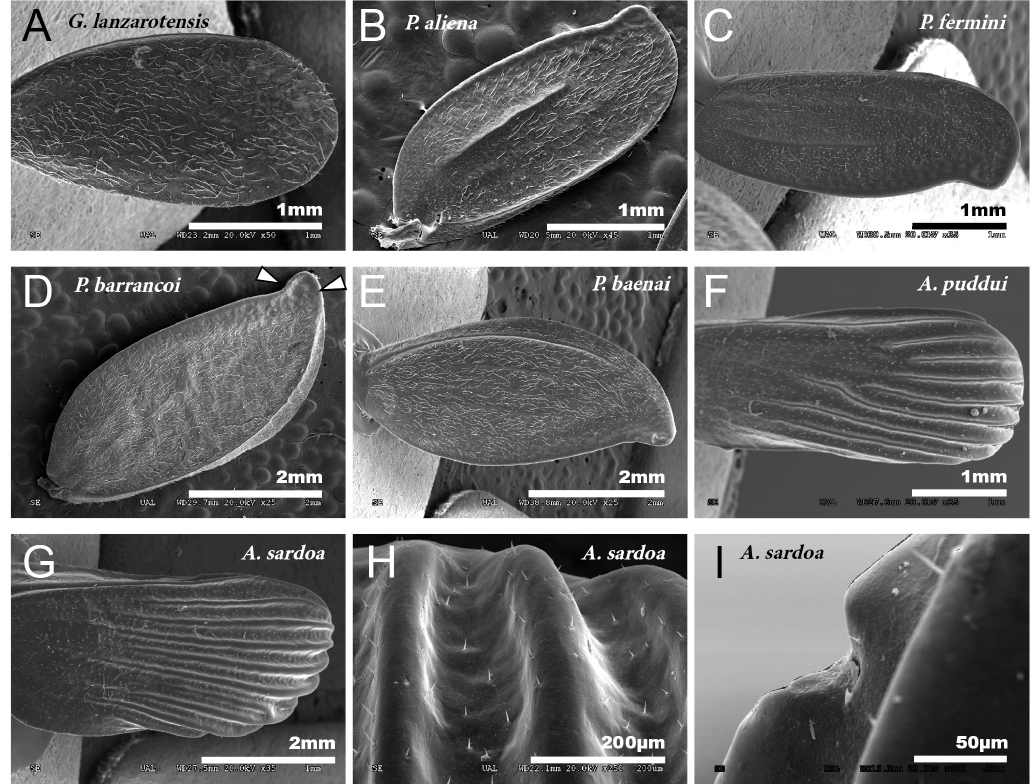
Figure 1. Tegmina. SEM images showing the morphology of the tegmina of male species of the tribes Gryllomorphini, G. lanzarotensis ( A ), and Petaloptilini ( B – H ). ( A ) Has no notchings or veins. In Petaloptilini ( B – H ), both notchings and veins depend on the genus or subgenus. The Iberian species of the genus Petaloptila have apical notchings ( B – E ) and variable and differently defined veins. P. aliena ( B ) and P. fermini ( C ) have well-marked veins. In contrast, Zapetaloptila has a single vein on the costal margin: P. barrancoi ( D ) and P. baenai ( E ). ( D ) Two glandular grooves associated with the apical notch of the tegmen are indicated. In the case of the genus Acroneuroptila the ribbing forms very pronounced ridges in A. puddui ( F ) and A. sardoa ( G , H ); in addition, there is a very reduced notch ( I ).